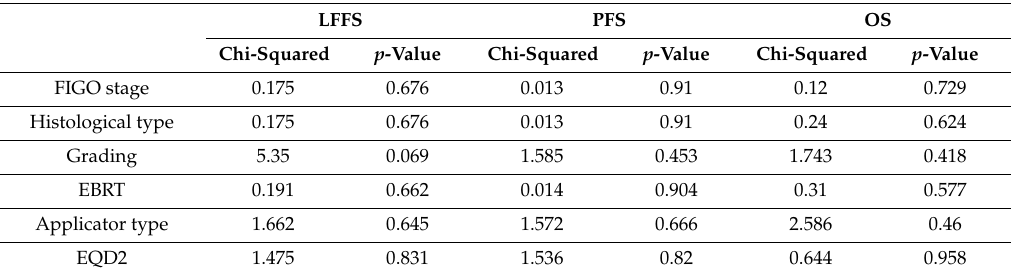
Table 4. Survival time comparisons of di ff erent group